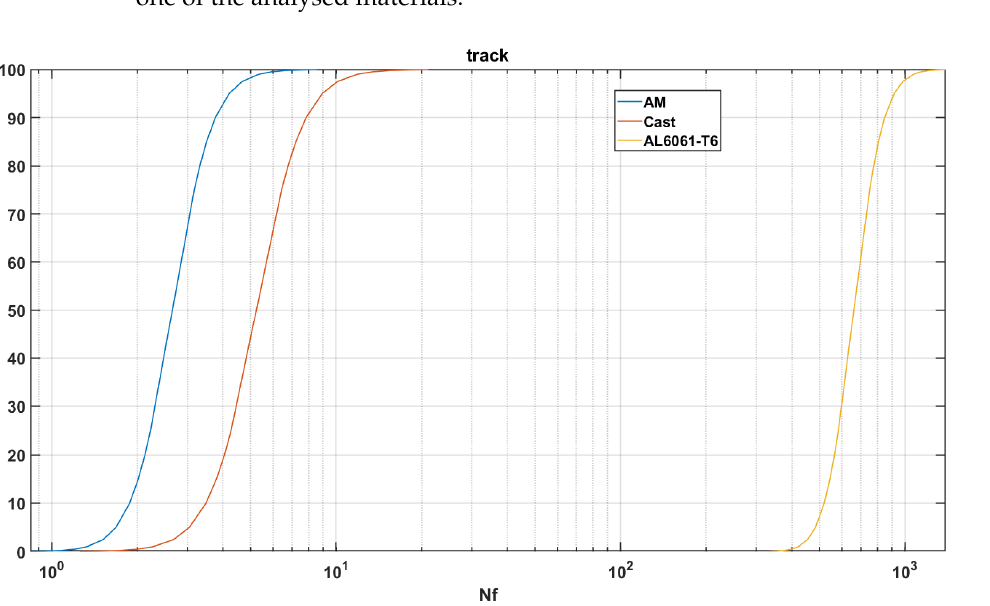
Figure 12. Fatigue lifetime distribution function of loading history consisting of 5 ditches, 20 stairs and 4